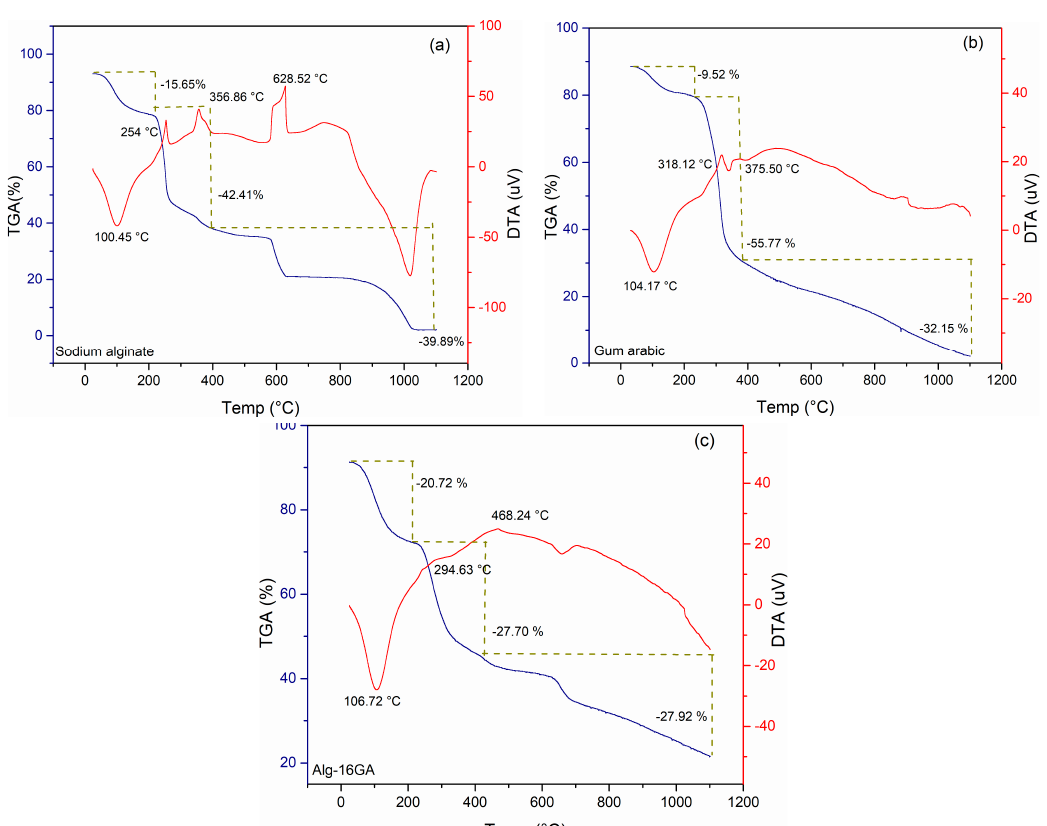
Figure 10. DTA and TGA curves of sodium alginate ( a ), gum arabic ( b ), and Alg-16GA ( c ). Blue lines represent TGA curves, and red lines represent DTA curves.